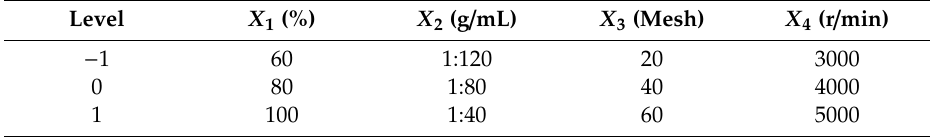
Table 3. Box–Behnken design (BBD) for the independent variables and corresponding response values. Level X 1 (%) X 2 (g / mL) X 3 (Mesh)